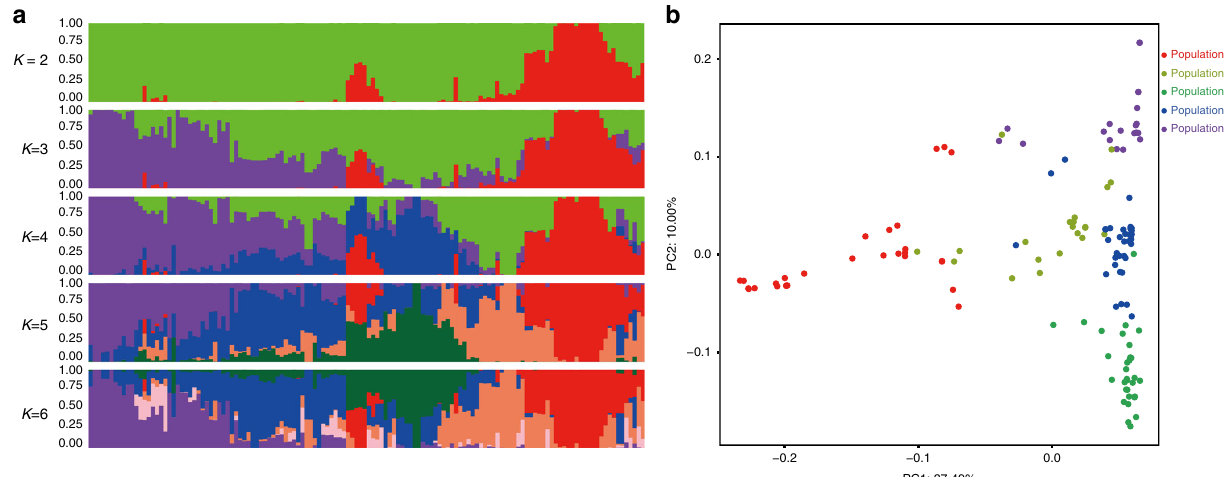
Fig. 2 Population structure of 134 representative tea plant accessions in China. a Model-based clustering analysis with different K -values (number of clusters). The optimal K -value is 5 as determined by the Harvester software. b PCA analysis using SNP allele data showing the genetic distances among tea plant accessions in fi ve groups identi fi ed in a . Source data are provided as a Source Data fi le.